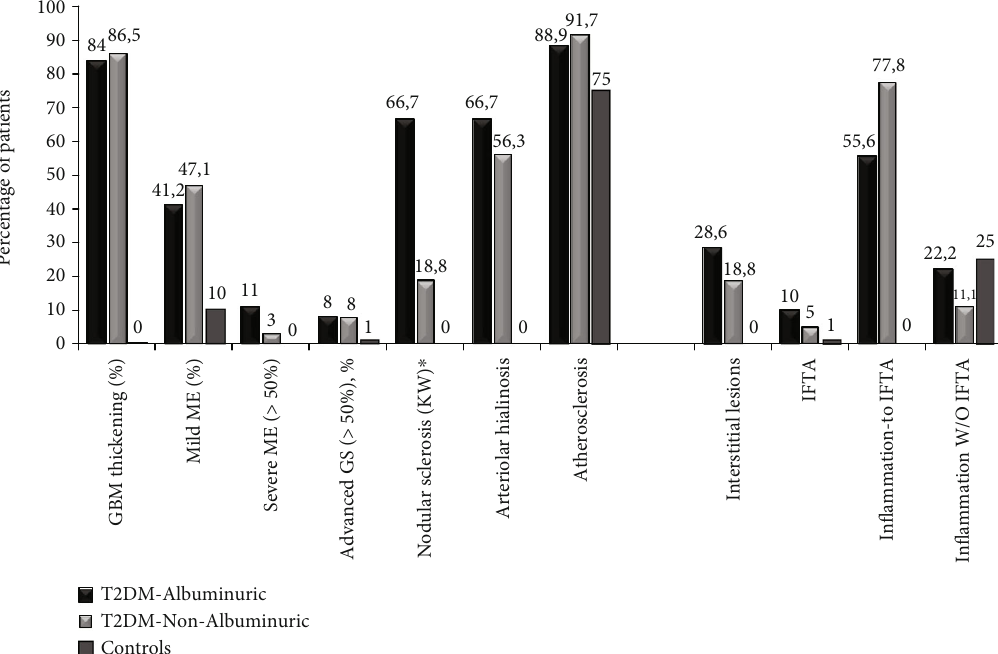
Figure 2: Percentage of patients with di ff erent histologic lesions. (a) Glomerular lesions. (b) Interstitial lesions. The number of glomeruli evaluated in each group was albuminuric patients 113 [94 – 228.5], nonalbuminuric patients 159.5 [120.75 – 213.5], and controls 129.5 [82.25 – 186.5]. There were signi fi cant di ff erences in all lesions when comparing diabetic patients and nondiabetic controls. No signi fi cant di ff erences were found when comparing albuminuric and nonalbuminuric T2DM patients except for the presence of nodular sclerosis ∗ ( p = 0 : 031